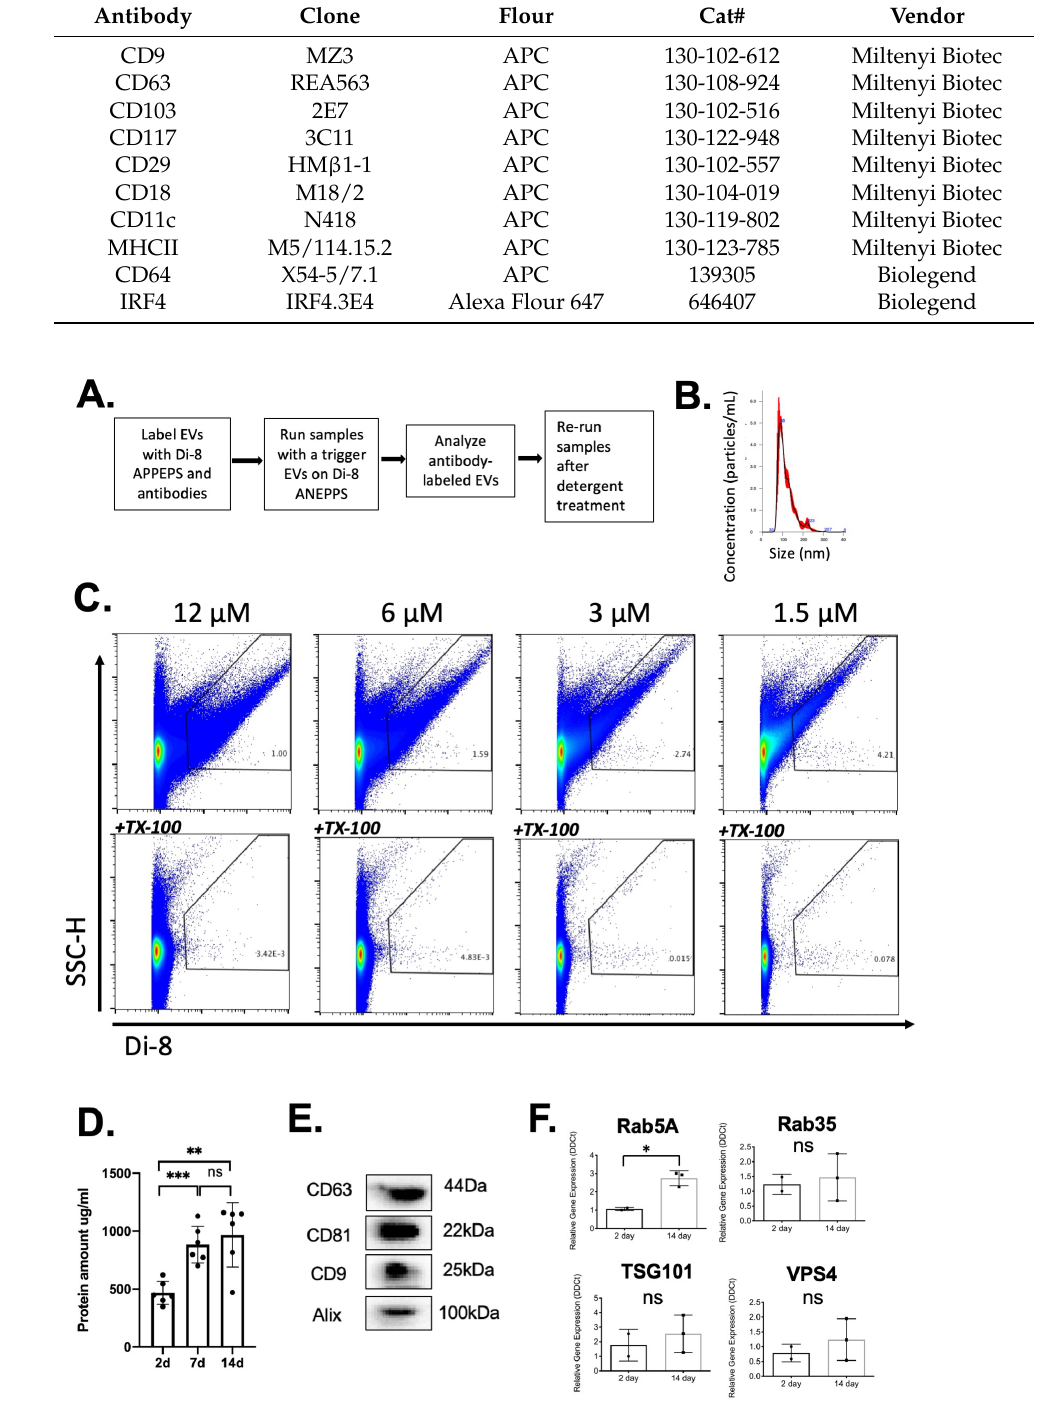
Figure 5. Characterization of EVs released in the PVA sponge model in C57 BL/6 mice. ( A ) Summary of vFC analysis. ( B ) NTA analysis of size distribution of EVs following ultra-centrifugation. ( C ) Analysis of EVs labeled with di-8 ANEPPS (top row), and gating on Triton-X100 detergent sensitive EVs (bottom row). ( D ) Quantification of protein concentration at 2, 7 and 14 days post-implantation used to normalize vFC analysis of EVs. Data shown are mean SD ( n = 5; * p < 0.05, ** p < 0.01, ± and *** p < 0.001). ( E ) Immunoblotting of EVs to detect Alix, CD9, CD63, and CD81 at 14 days post-implantation of PVA sponges. ( F ) The gene expression analysis of genes associated with EV biogenesis in PVA cells recruited to PVA sponge at 2 and 14 days (* p < 0.05, ns = not